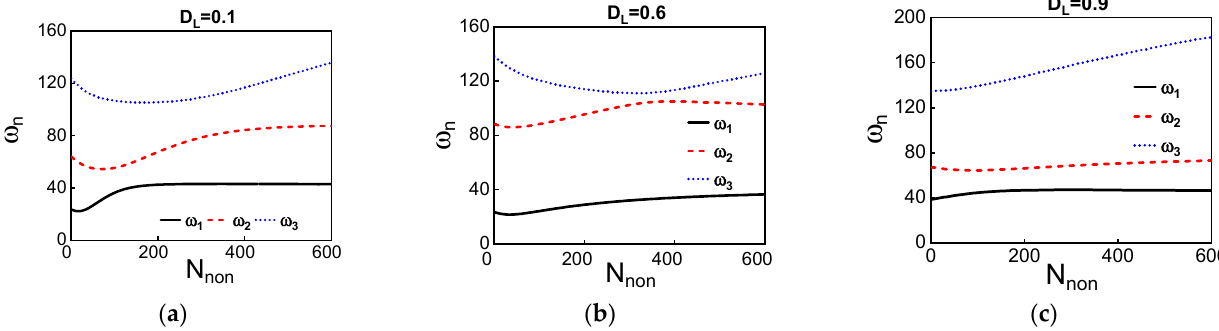
Figure A3. ( a – c ): The variation of the three lowest natural frequencies with axial load for different dome lengths. The initial rise of the dome is equal to 3 μ m.